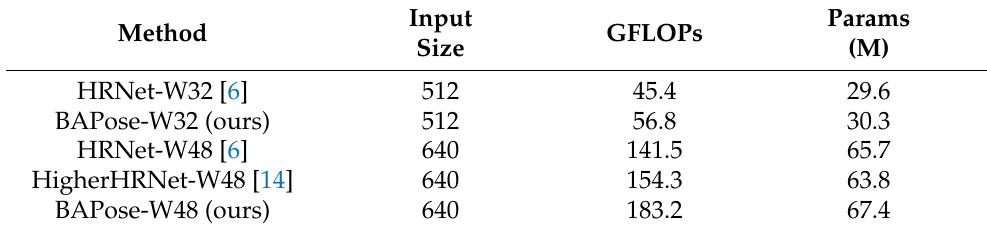
Table 3. GFLOPs and number of parameters